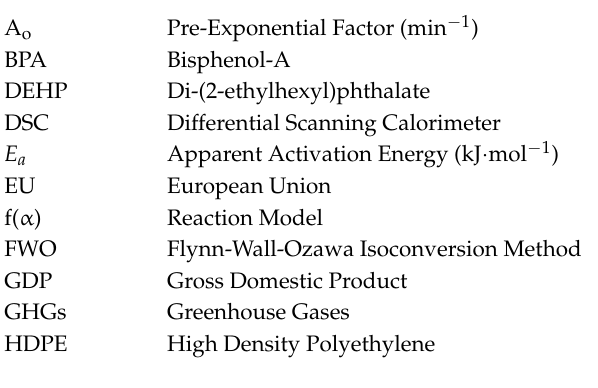
Figure S1: The various stages of the recycling procedure undertaken in this work showing (a) reclaimed plastic waste at landfill site, (b) storage of waste material, (c) transportation, (d) milling machine assembly, finally; (e) compounding of blends; Figure S2. Plate of (a) control specimens and (b) samples past the threshold limit in the accelerated weathering chamber (16 days). Source: Al-Salem [54]; Figure S3. Accelerated weathering procedure showing the (a) weathering chamber, (b) samples mounted on the exposure racks, (c) drying of samples Table S2: Degree of crystallinity (%) measured for the studied samples before and after exposure to threshold limit of accelerated weathering, Table S3: TG thermograms for the unexposed materials, Table S4: TG thermograms for the materials exposed to threshold